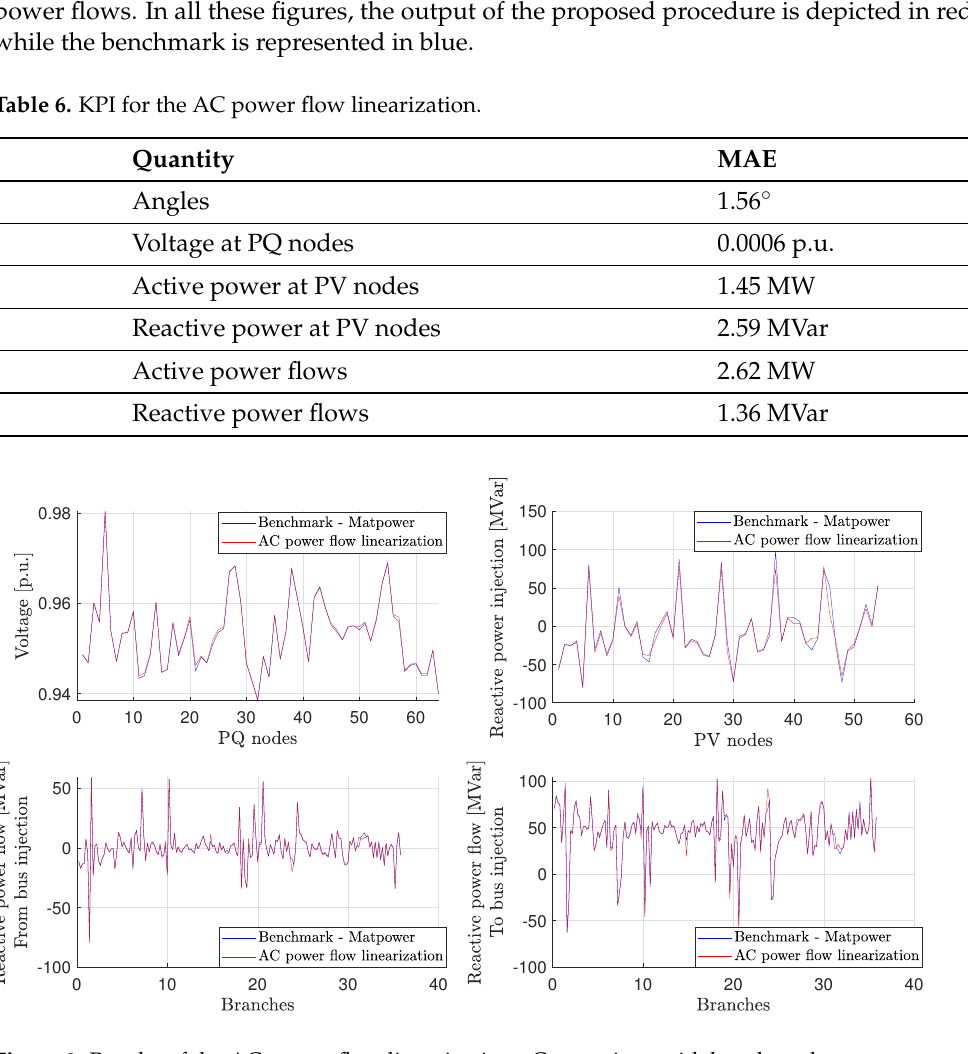
Figure 2. Results of the AC power flow linearization − Comparison with